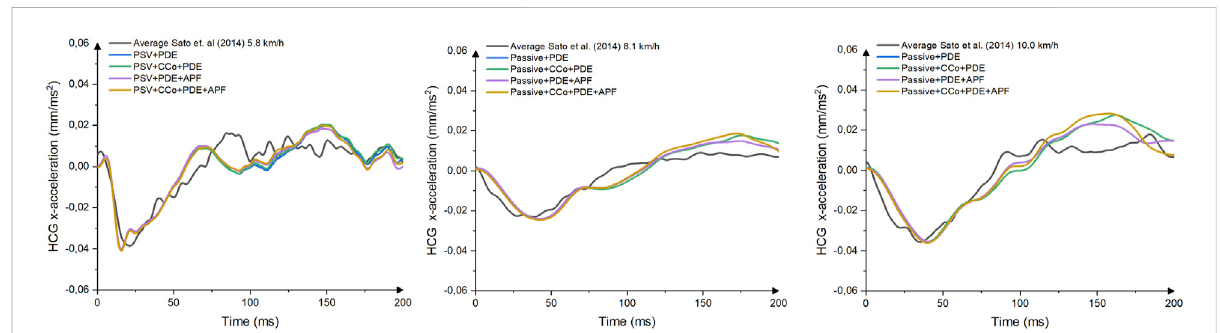
FIGURE 6 Comparison of Head C.G x-Acceleration between Female Models with Various Complexities and Volunteer Kinematics from Sato et al. (2014) 5.8 km/h, Sato et al. (2014) 8.1 km/h, and Sato et al. (2014) 10